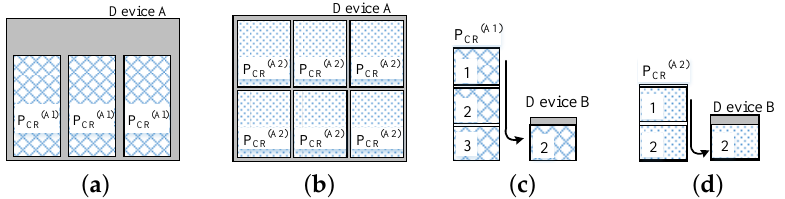
Figure 12. The analysis of throughput and the AHCF in device. ( a ) The implementation of a big P CR algorithm in an abundant resources device. ( b ) The implementation of a small P CR algorithm in an abundant resources device. ( c ) The implementation of a big P CR algorithm in an insufficient resources device. ( d ) The implementation of a small P CR algorithm in an insufficient resources device.